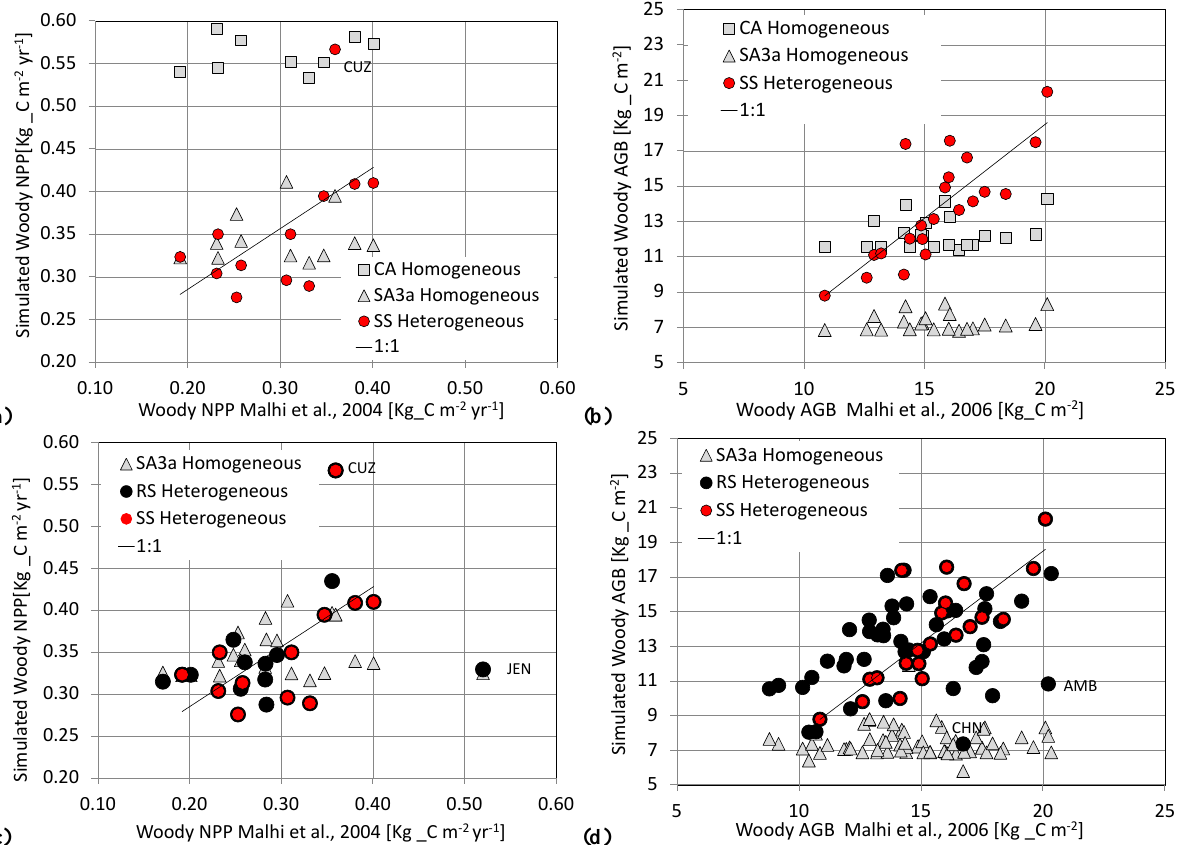
Fig. 7. Comparison of IBIS-simulated values with field observations. Figures on the left (a, c) are comparisons of woody above-ground net primary productivity. Figures on the right (b, d) are comparisons of woody above-ground live biomass. (a) and (b) are IBIS-simulated results, only for grid cells where the V cmax (Series A) and woody residence time (Series B) are known; while (c) and (d) are the IBIS-simulated results for the full series of data where NPP w and AGB w field data are available (Series A+B and C+D).